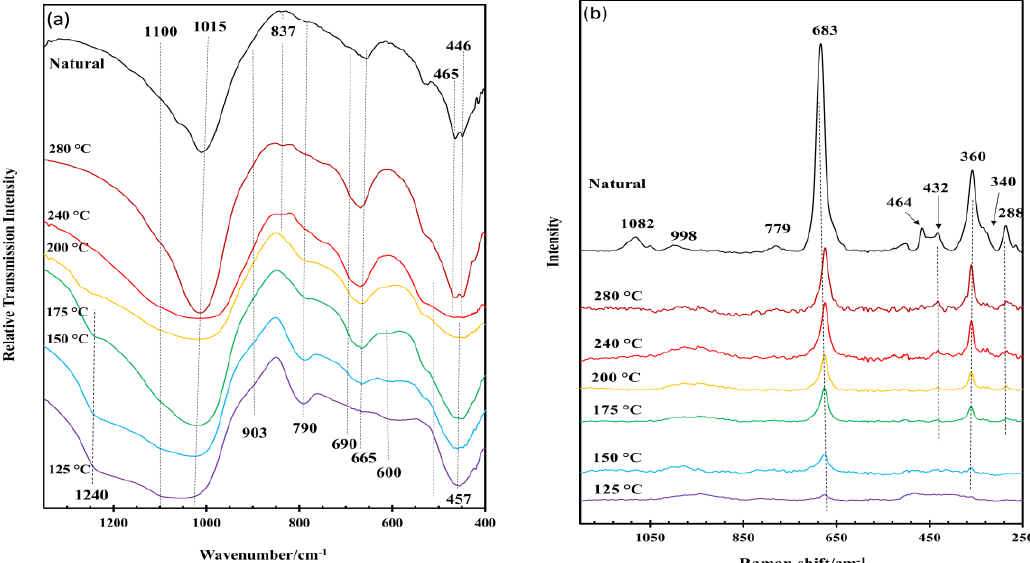
Figure 6. ( a ) Mid-IR spectra of of synthetic NH 4 -saponite synthesized at temperatures between 125 and 280 ◦ C in comparison to Milford saponite between 1350 and 400 cm − 1 ; ( b ) Raman spectra of the same samples in the region between 1200 and 250 cm − 1 (modified after